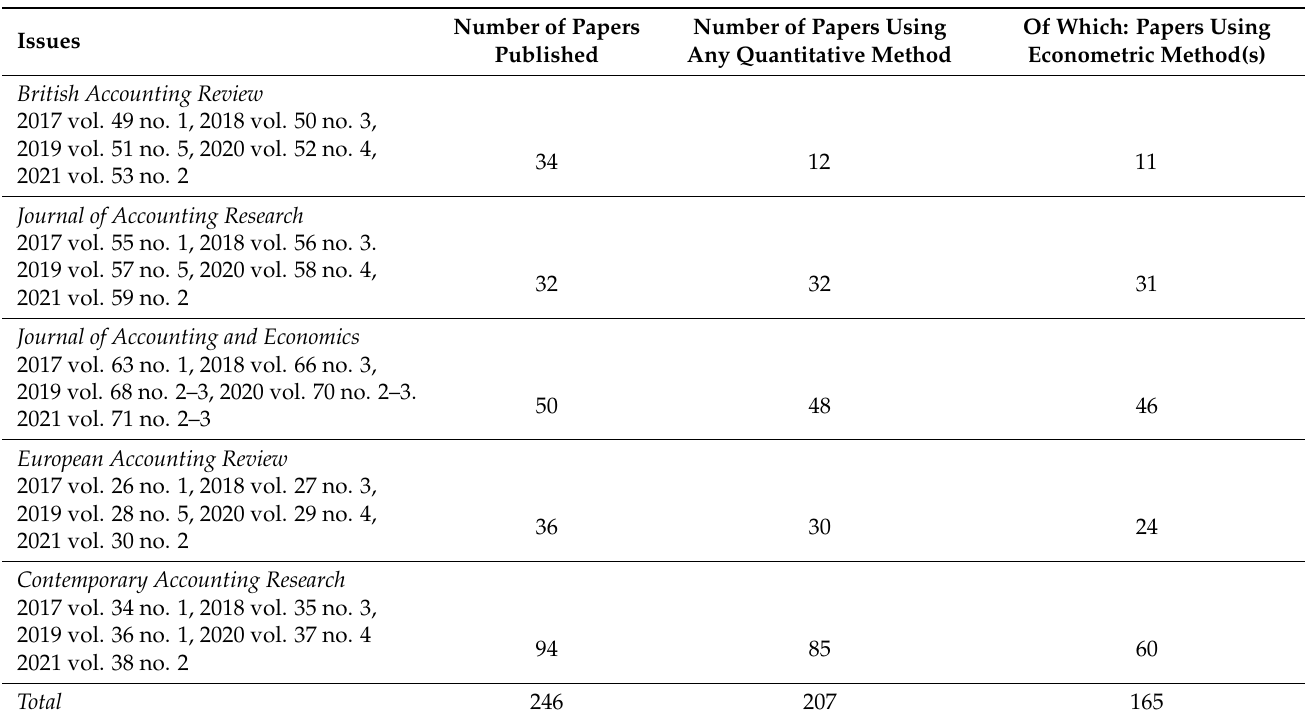
Table 2. Accounting journals, the list of issues, the number of papers using quantitative/econometric